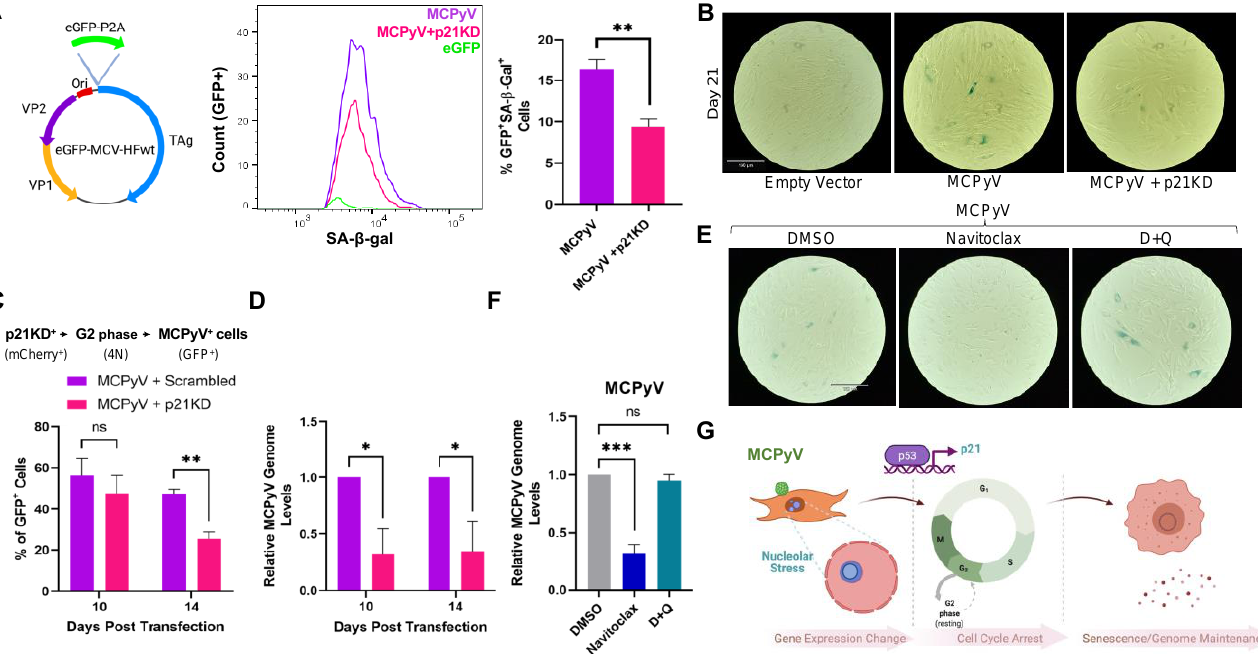
Figure 6. MCPyV − induced senescence is required for viral genome maintenance. ( A ) p21 knockdown decreases the percentage of senescent SA − β − gal + cells. Schematic representing whole MCPyV genome construct encoding origin (Ori), VP1, VP2, T antigens (TAg), and eGFP − P2A (left). BJ − hTERT cells were reversely transfected with the MCPyV genome and then transduced with shp21.1 for p21 knockdown at 14 days post − transfection. At 21 days post − transfection, MCPyV − transfected cells were subjected to a senescence assay. Histogram representing GFP + /SA − β − gal + (MCPyV + , senescent cells) for transfected MCPyV or MCPyV+p21KD cells (middle). Percentage of GFP + /SA − β − gal + in population (right). Statistical significance was determined using unpaired Student ’ s t -test (** p < 0.01). Standard error bars represent mean value with standard error: n = 3; 10,000 cells recorded per replicate. ( B ) MCPyV − induced senescence is p21 − dependent. Colorimetric SA − β − gal staining of MCPyV − transfected cells at 21 days post − transfection. ( C ) Cellular senescence maintains MCPyV genome. BJ − hTERT cells were co − transfected with MCPyV (GFP+) and mCherry − shScr or mCherry − shp21.1 (p21KD, mCherry + ). Cells were harvested at the stated days post − transfection and were analyzed by flow cytometry. Transfected cells were gated for mCherry + (p21KD) cells and then examined for G2 − arrested GFP + cells (MCPyV + ). Unpaired Student ’ s t -test (ns = not significant). Standard error bars represent mean value with standard error, n = 3. ( D ) qPCR was conducted on cells reversely co − transfected with mCherry − shScr or mCherry − shp21.1, and MCPyV genome levels were reported at the given time points. Multiple unpaired Student ’ s t -test (* p < 0.05). Standard error bars represent mean value with standard error, n = 3. ( E ) Senolytic treatment selectively clears MCPyV − induced senescent cells. At 14 days post − transfection, empty vector − or MCPyV − transfected cells were treated with navitoclax (250 nM), dasatinib and quercetin (D+Q, 25 nM dasatinib and 250 nM quercetin), or DMSO for two days, and then subjected to a SA − β − gal assay or qPCR ( F ). Scale bar = 180 μm. One − way ANOVA (*** p < 0.001). Standard error bars represent mean value with standard error, n = 3. ( G ) MCPyV induces senescence to sustain viral genome maintenance. MCPyV LT activates p53 and, subsequently, p21 through nucleolar stress responses. Activation of p21 induces G2 cell cycle arrest, leading to changes in growth arrest and senescent gene expression, as well as the promotion of cellular senescence. Cellular senescence establishes MCPyV infection in fibroblast cells, enabling it to extend its lifecycle within the host. Figure created with BioRender.com. 3. Discussion Taken together, our results show that MCPyV infection, mainly MCPyV LT expression, can activate a nucleolar stress response in human fibroblast cells. This, in turn, activated p53 transcriptional activity, inducing p21 expression. p21 upregulation subsequently led to G2 cell cycle arrest, promoting cellular senescence. MCPyV was able